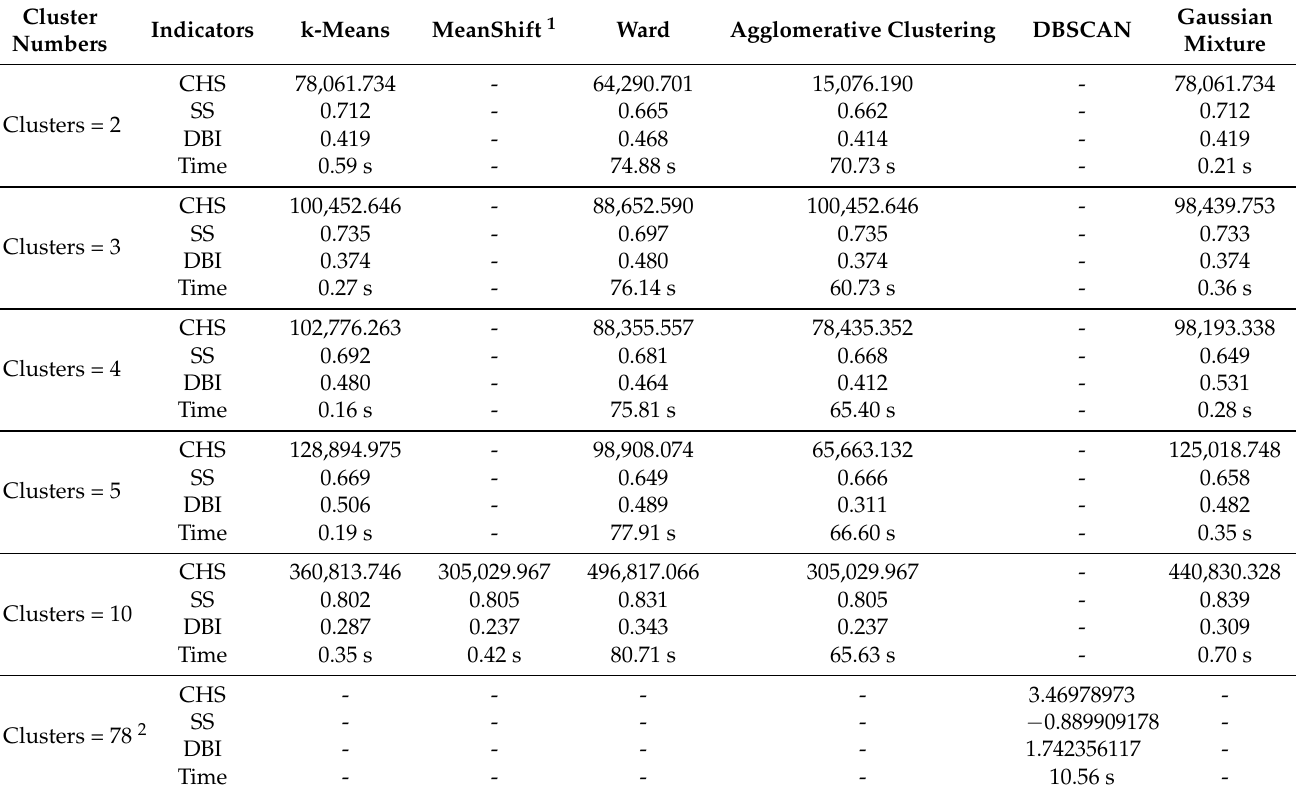
Table 3. The performance indicators of six clustering methods with corridor data.